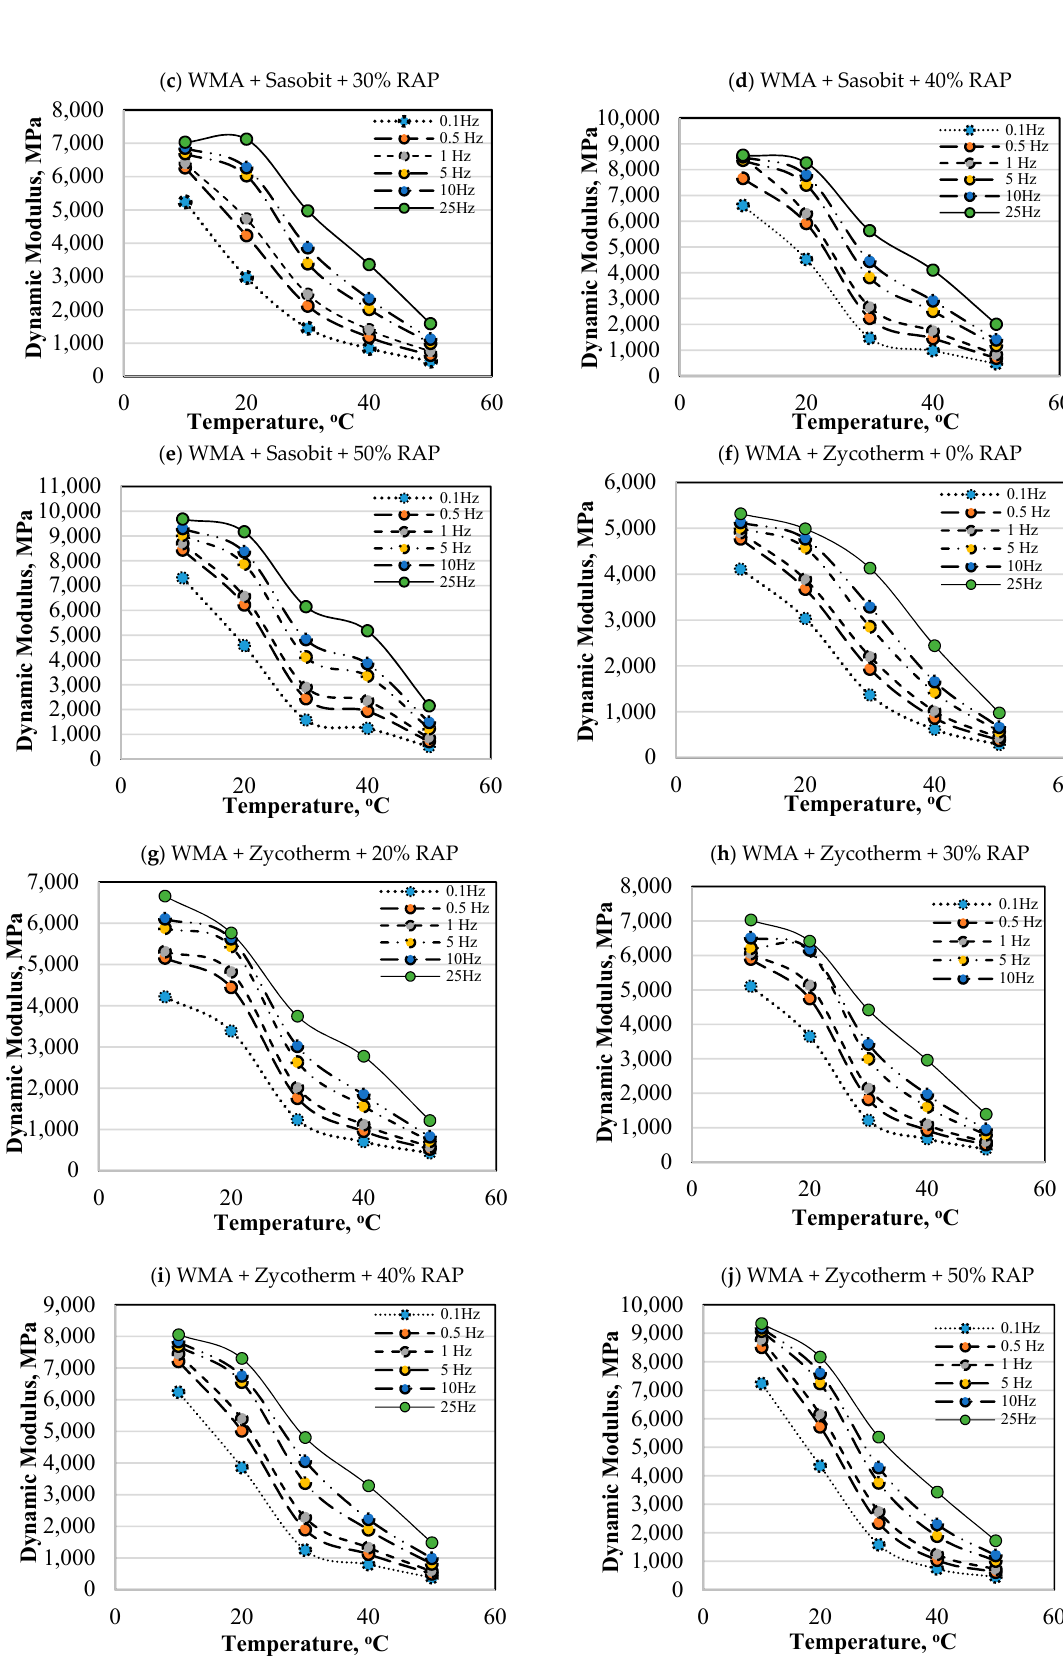
Figure 4. Experimental results of Dynamic Modulus (E*) vs. temperature in function of different asphalt mixtures and RAP contents.